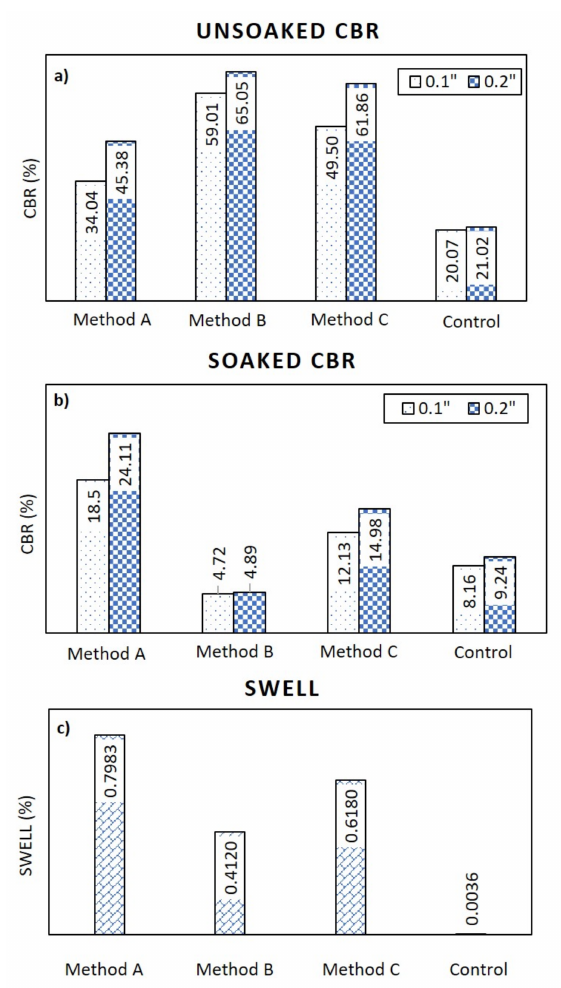
Figure 16. CBR test results for different mixing methods and conditions: ( a ) unsoaked ( b ) soaked ( c )